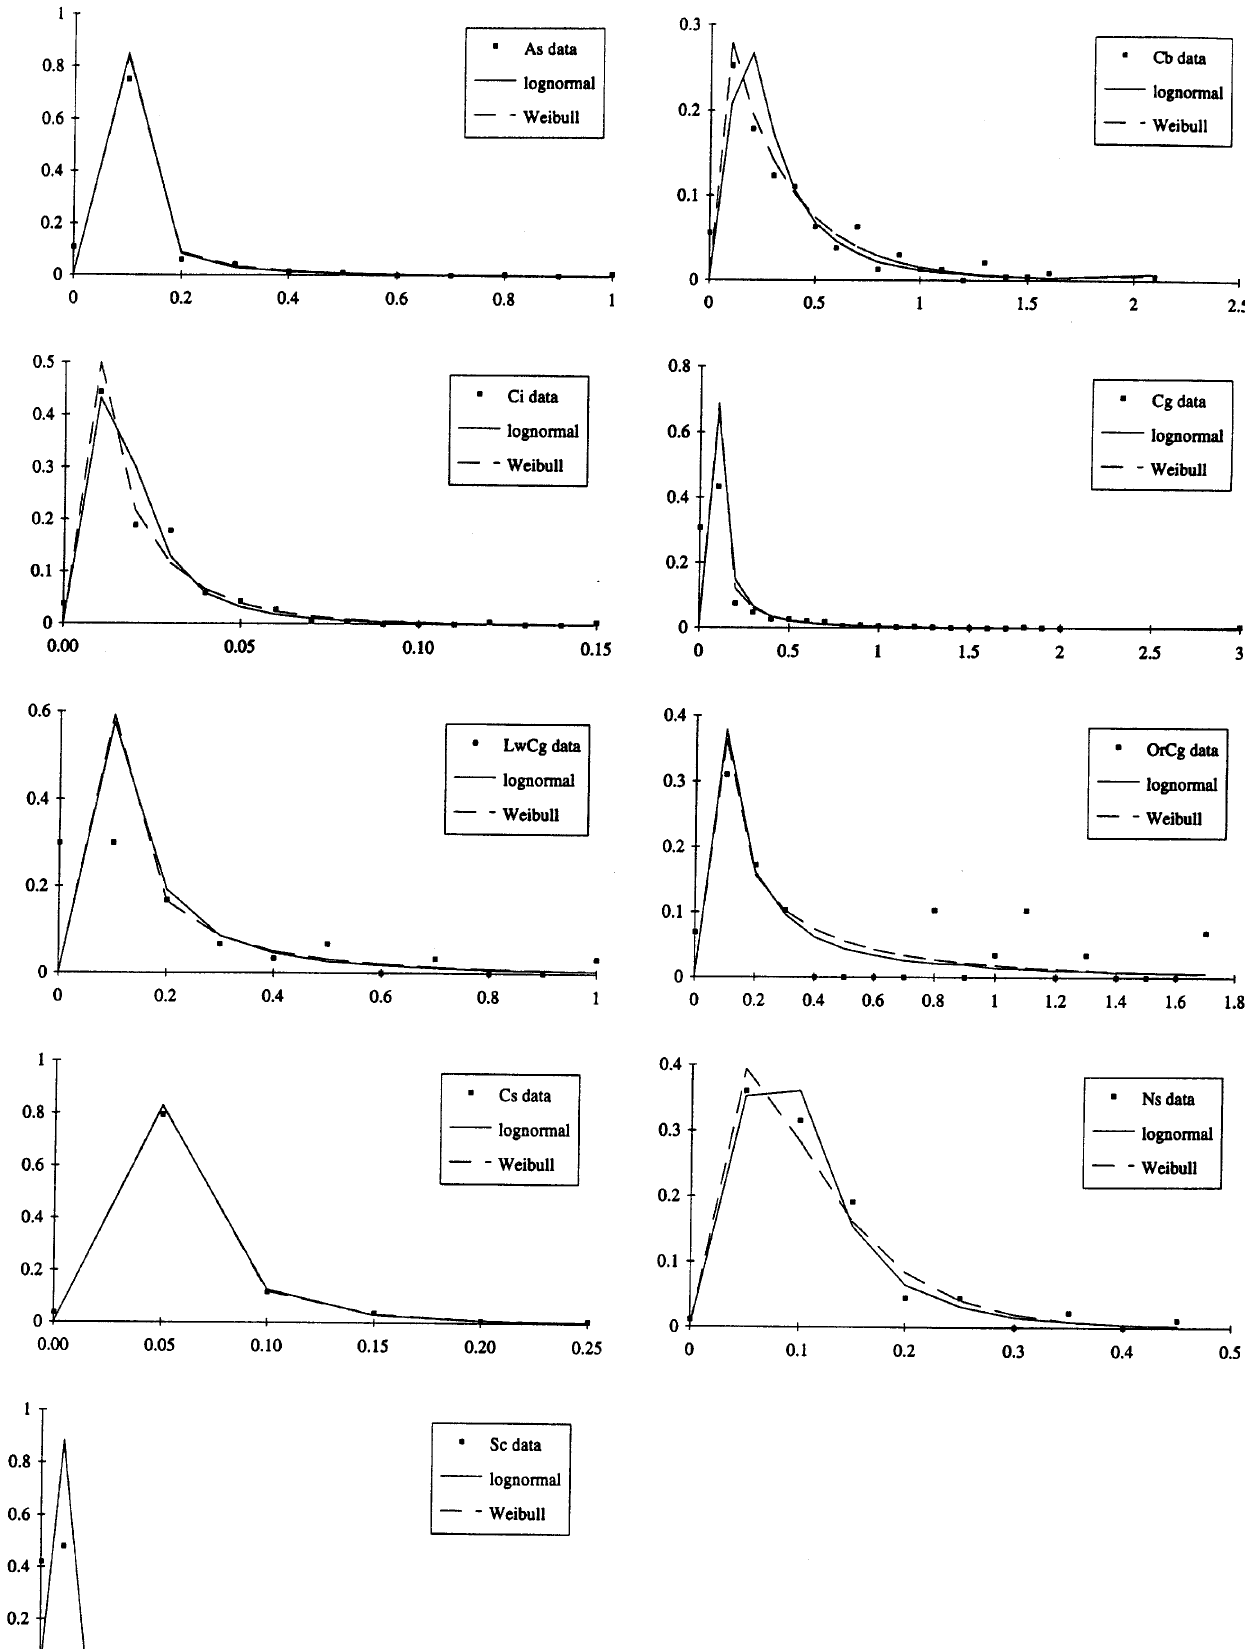
Fig. 10. Frequency distributions of water content IWC fitted in Sects. 4 and 5 plotted together with